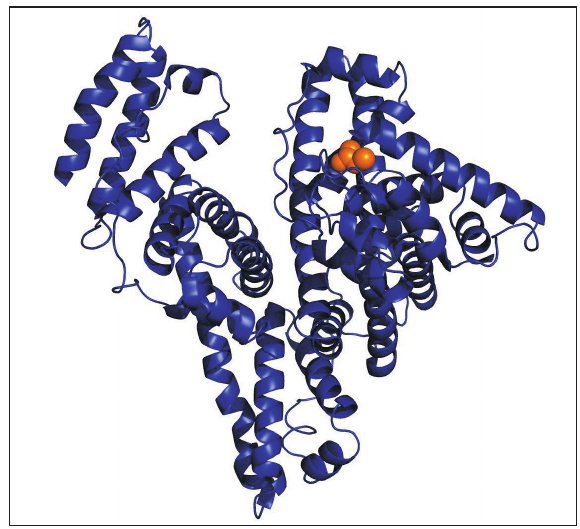
Figure 1. Three-dimensional structure of human serum albumin. Cysteine 34 is shown in orange. Atomic coordinates were down- loaded from the Protein Data Bank, accession code 1AO6 (7). The figure was prepared using PyMOL v0.99